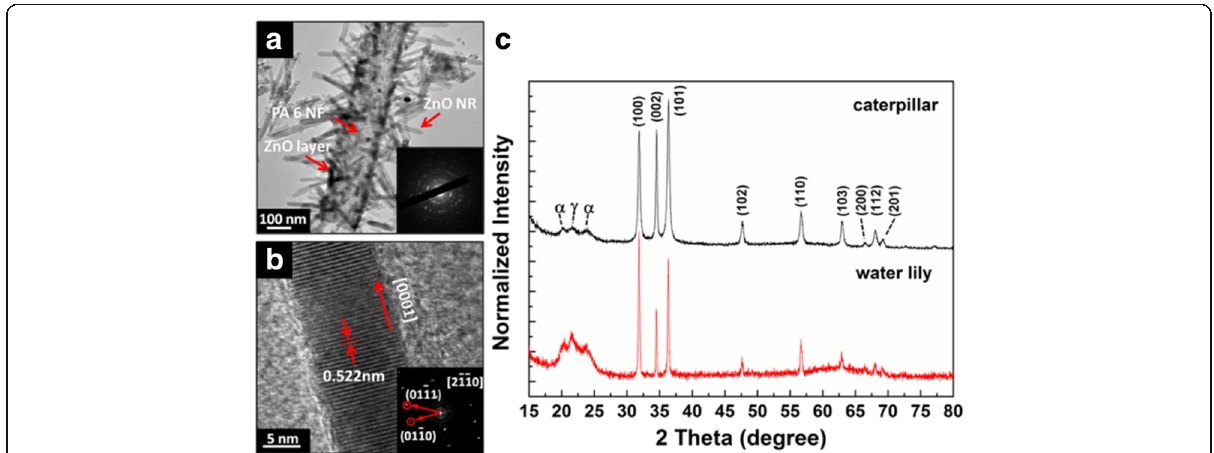
Fig. 4 a TEM image of caterpillar-like hierarchical nanostructure and corresponding SAED pattern as inset . b HRTEM and corresponding FFT images of a single ZnO NW. c XRD pattern of “ caterpillar ” - and water lily-like hierarchical